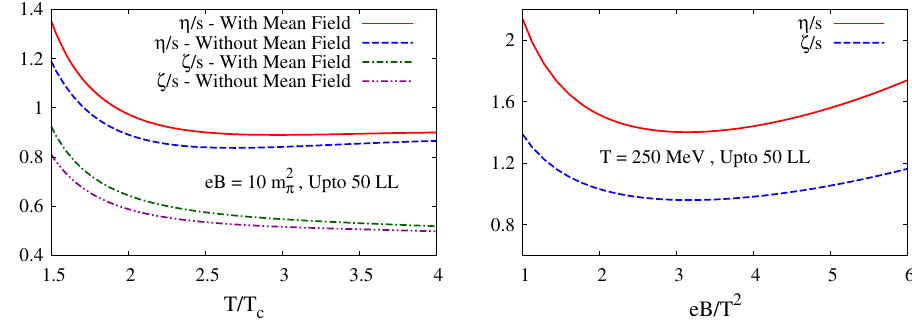
Fig. 4 Temperature dependence of ζ/ s and η/ s with and without mean field correction at | eB |= 10 m 2 π for 1 → 2 processes (left panel). Magnetic field dependence of ζ/ s and η/ s (right